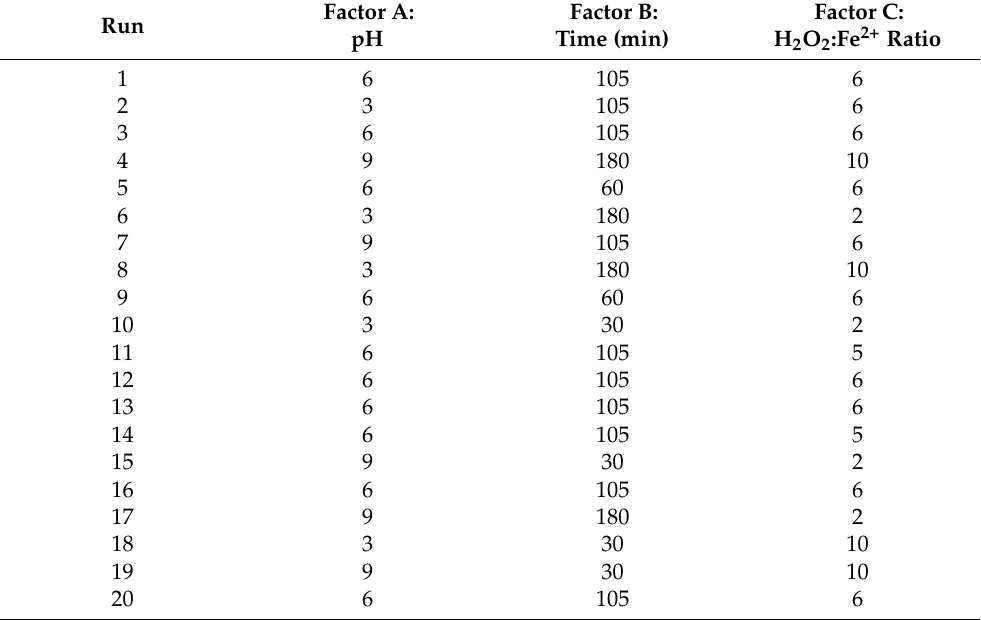
Table 2. Preliminary full factor design for color removal resulting from the Fenton